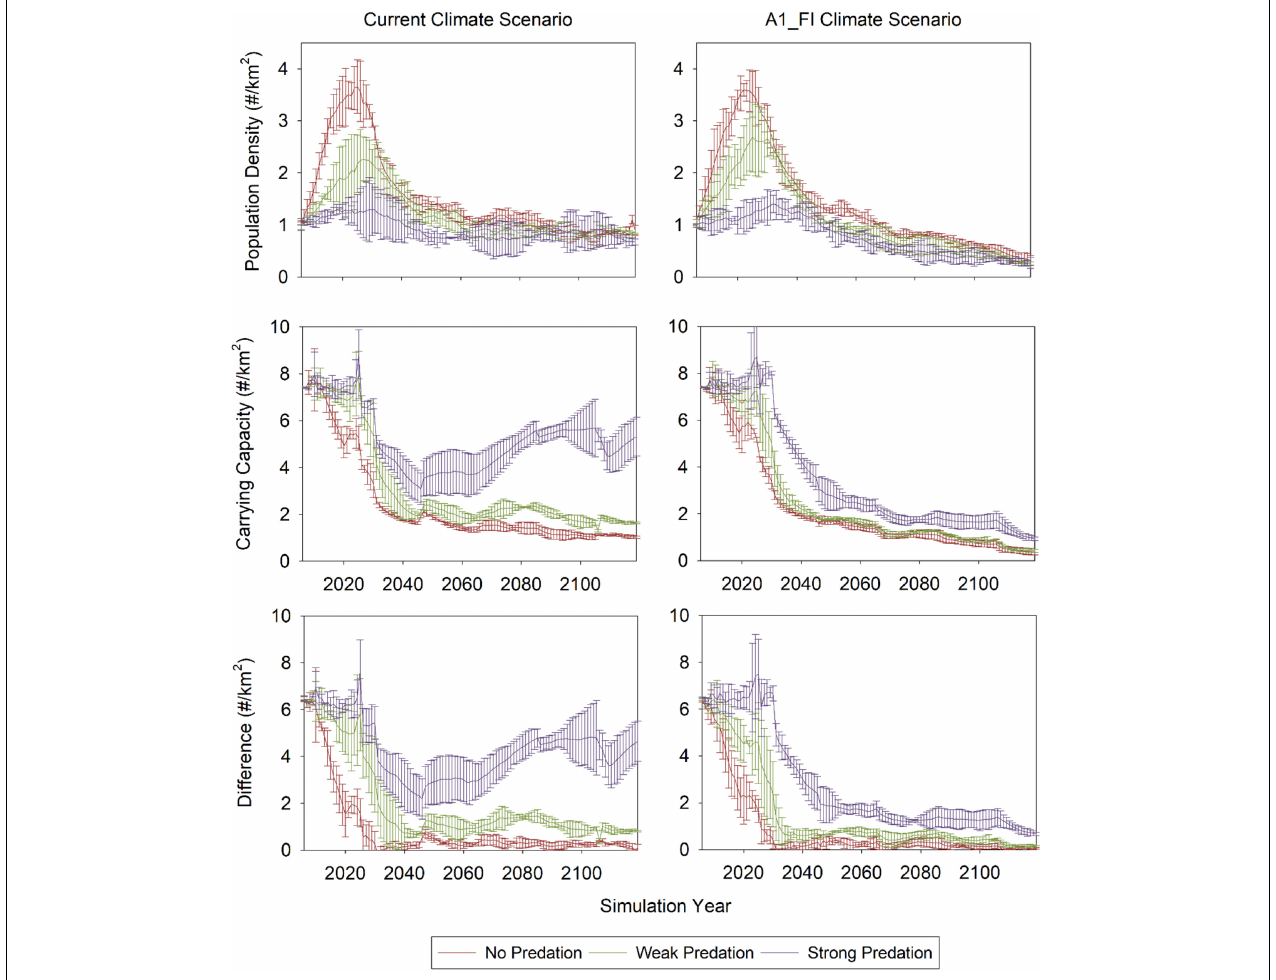
FIGURE 2 | Moose population density, carrying capacity, and the difference between the two for current climate (left) and high emissions scenarios (right) and three wolf predation scenarios. Data are area-weighted means ± 2 standard deviations from three replicate simulations within each scenario (climate ×